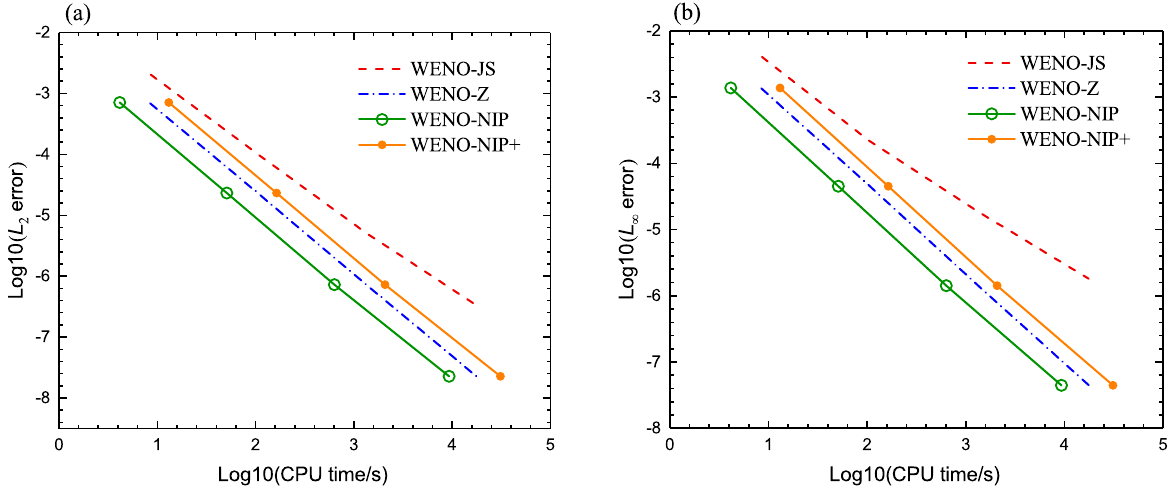
Figure 14. Comparison of various WENO schemes for Example 5 in CPU time and computing errors: ( a ) L 2 -norm error; ( b ) L ∞ -norm